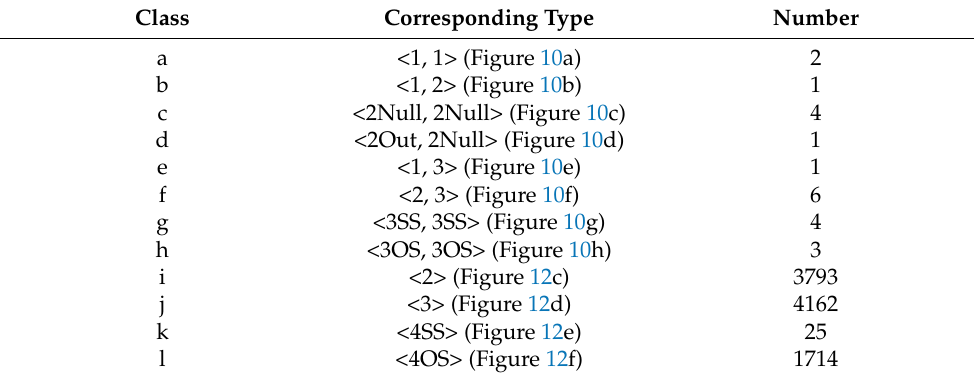
Table 2. Detection result of the topological conflict between traffic lines.